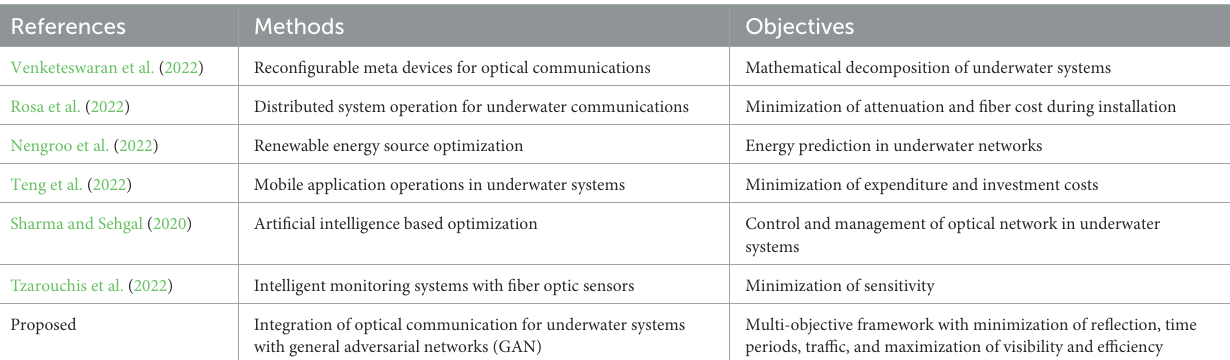
TABLE 1 Comparison with recent